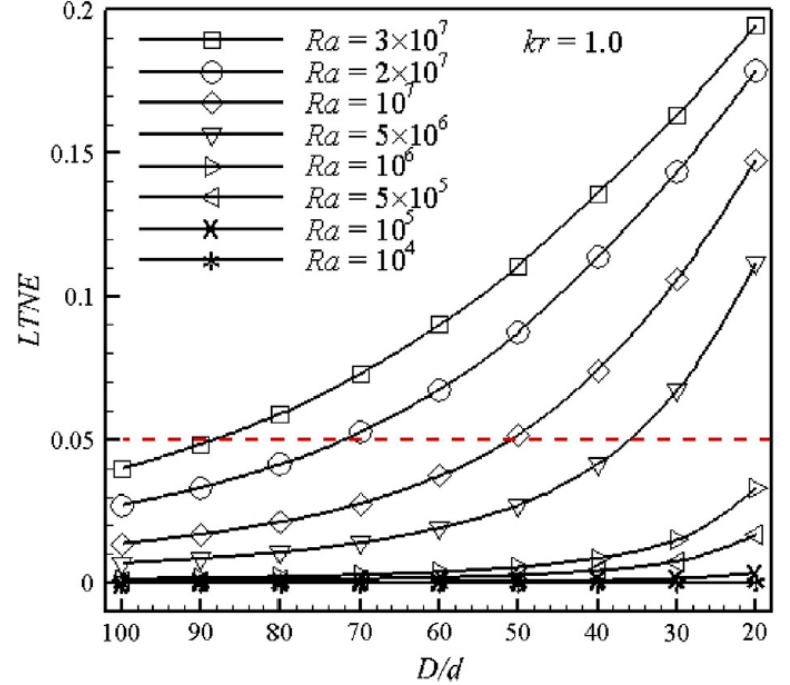
Figure 41. LTNE versus cylinder/particle diameter ratio ( D / d ) for different Rayleigh numbers, at ( kr = 1.0), presented by Al-Sumaily et al.